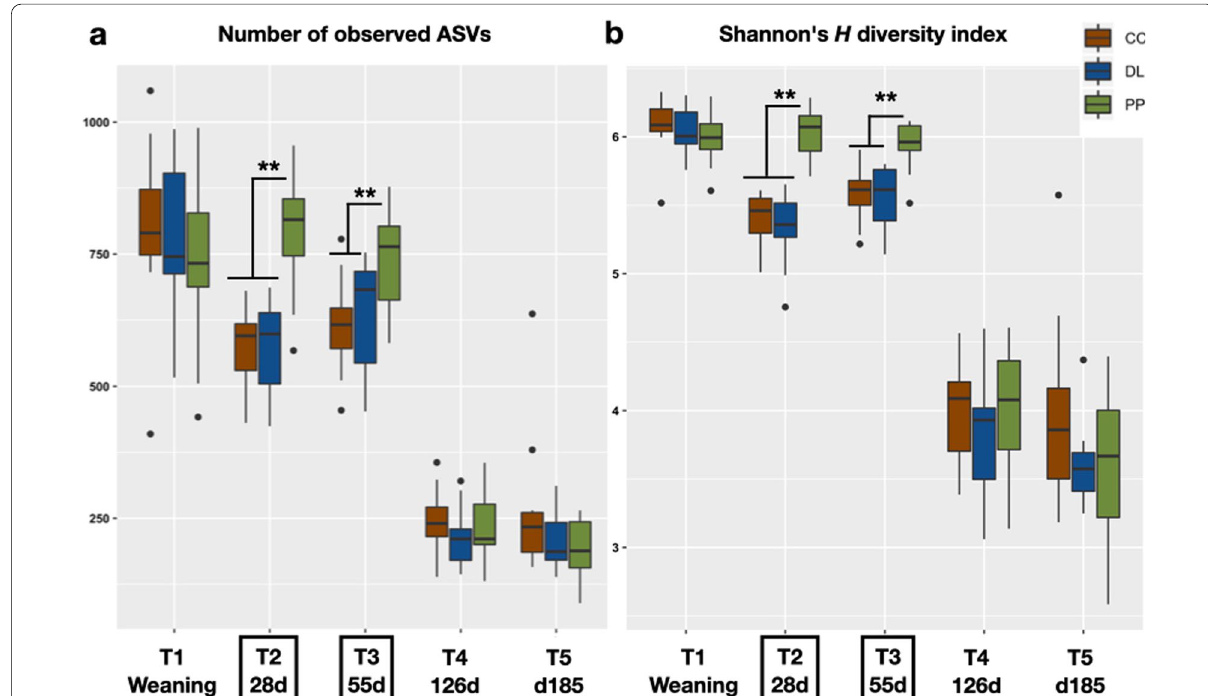
Fig. 3 Rumen bacterial alpha diversity at weaning (T1), backgrounding (T2–T3), and finishing (T4–T5). a The number of different ASVs detected decreased significantly for calves moved to DL and CC BKG, but remained stable for calves on PP during this period. This number decreased again for all BKG groups at the finishing stage. b The patterns observed with the number of different ASVs as shown in ( a ) were replicated when measuring the Shannon index of diversity, which not only takes into account presence or absence of different ASVs, but also their abundance distribution. Dry lot (DL); cover crop (CC) and perennial pasture (PP). Asterisks show significant differences based on Kruskal–Wallis tests adjusted for multiple comparisons (**P < 0.001, ***P <